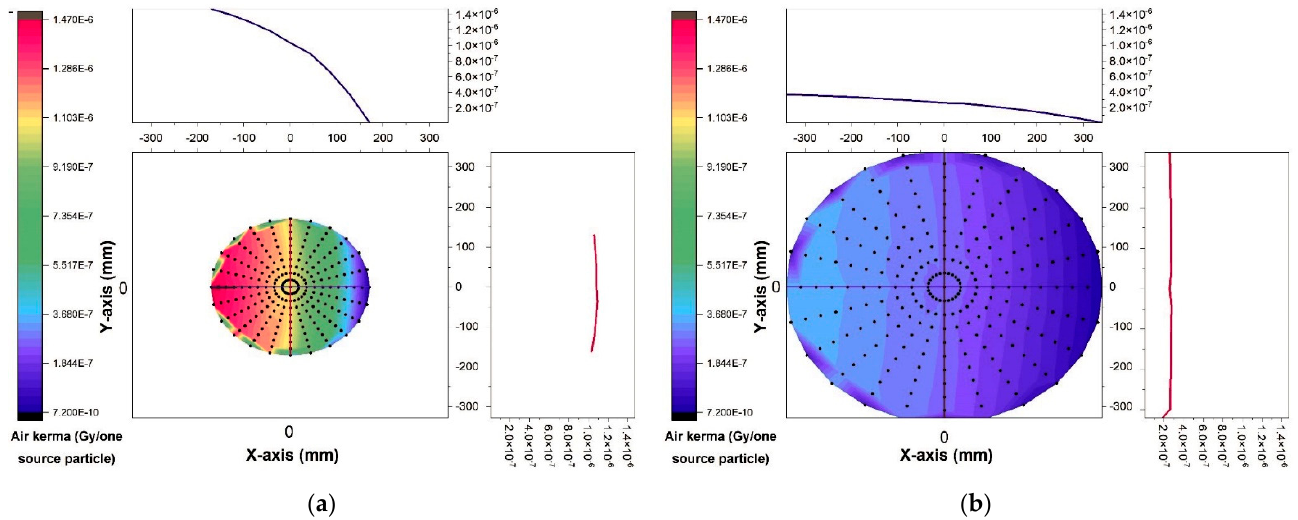
Figure 5. The air kerma determined with the help of the Monte Carlo method at ( a ) 500 mm and ( b ) 1000 mm. ( b ) 1000